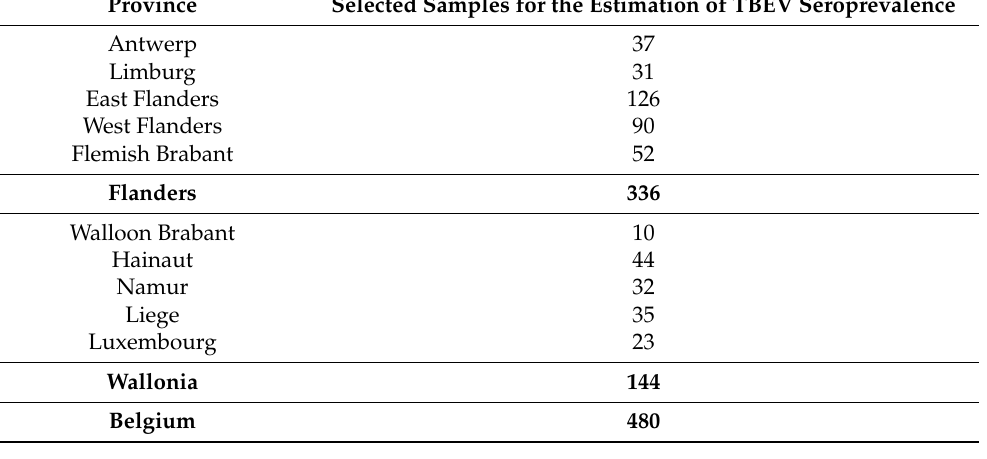
Table 1. Number of samples selected from each province.